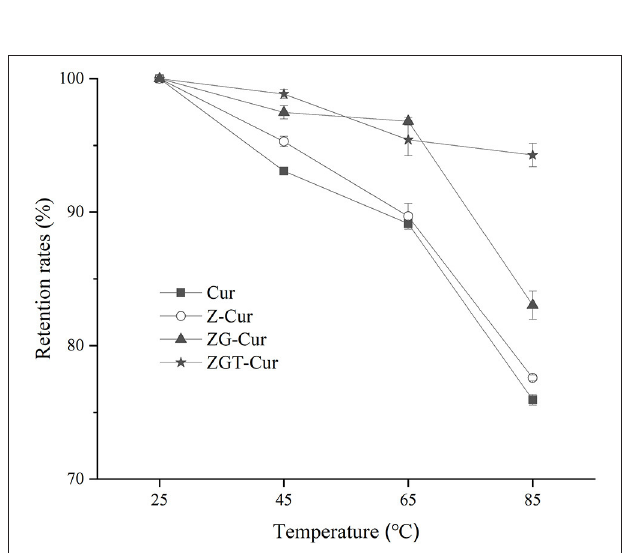
FIGURE 7 | First-order kinetic curve fitting of curcumin degradation during UV irradiation.